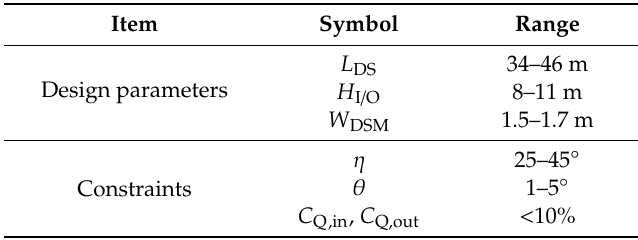
Table 1. Design parameters and